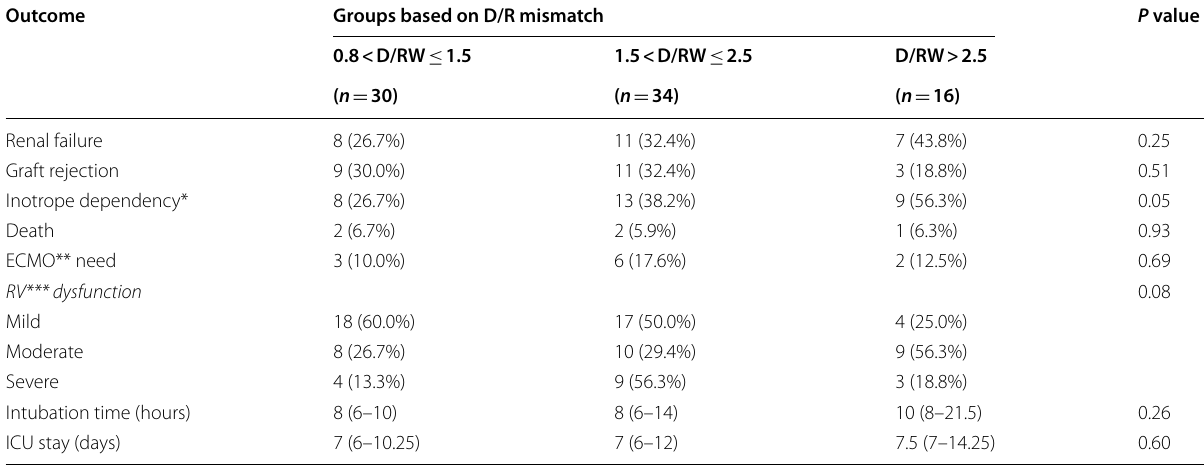
*Inotrope dependency was defined as vasoactive–inotropic score > 13 **Extracorporeal membrane oxygenation ***Right ventricle